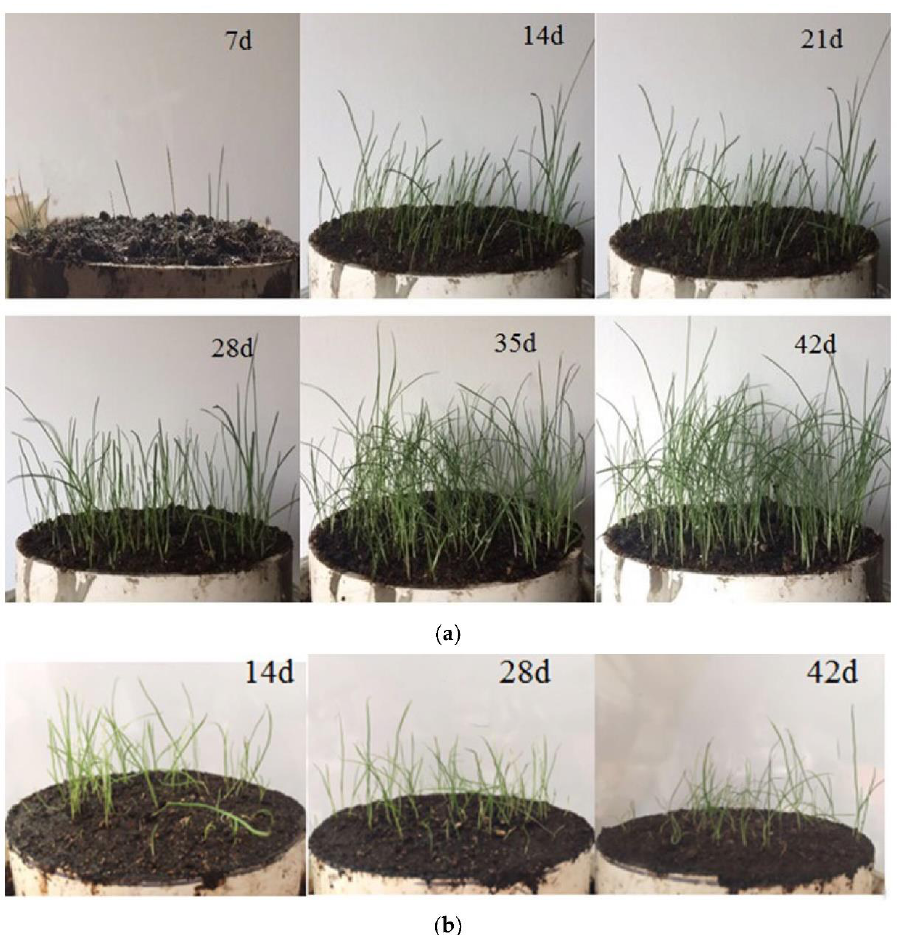
Figure 10. Plant growth status based on ( a ) MPC and ( b ) OPC .